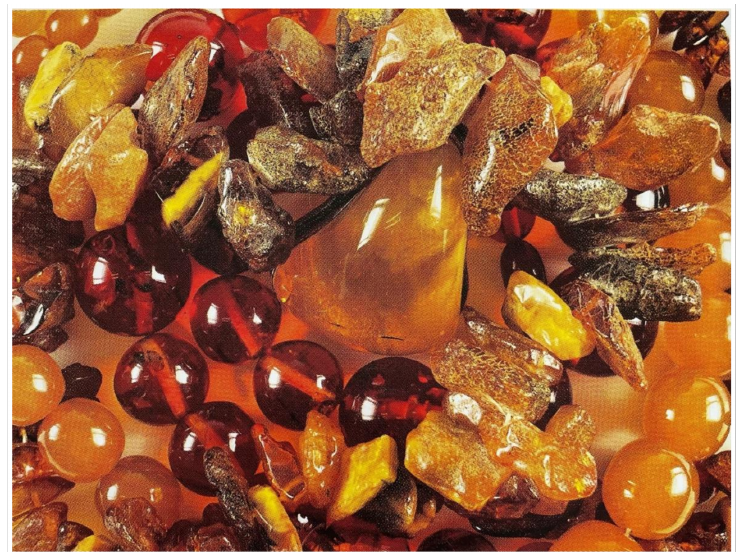
Figure A12. 25LPI, screen-print, 55H mesh, CMYK, printed Y, M, C, K, white Plike, film positive, print size: 600 mm × 450 mm.